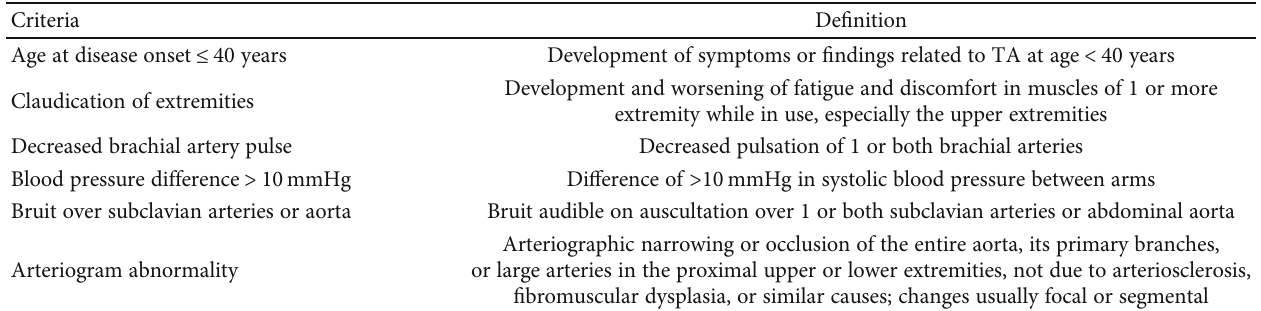
Table 2: The 1990 American College of Rheumatology classi fi cation criteria for Takayasu ’ s arteritis